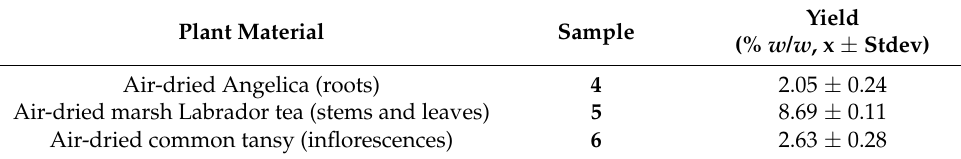
Table 2. The scCO 2 extraction yields of the selected plant materials.